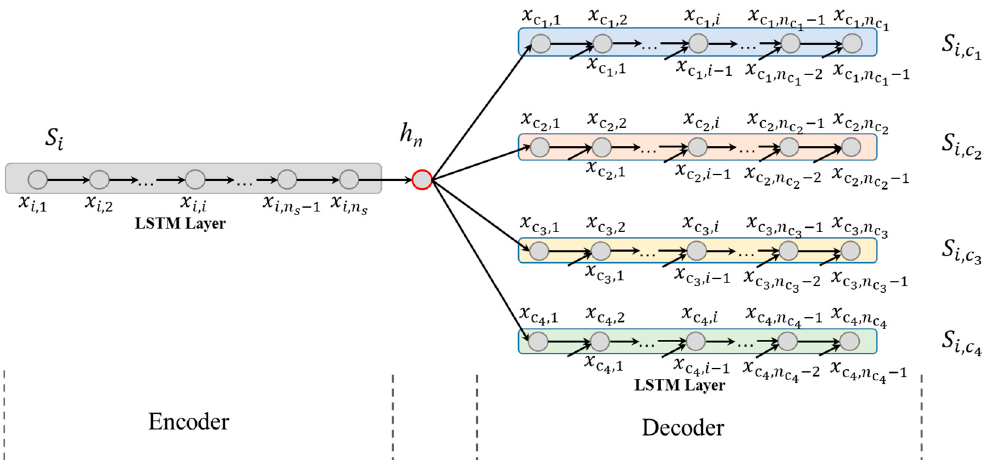
Figure 4. Latent semantic feature extraction model.